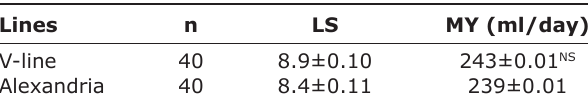
Table-1: Means and standard errors of LS and MY for V-line and Alexandria line rabbits during the 3 rd week of lactation.